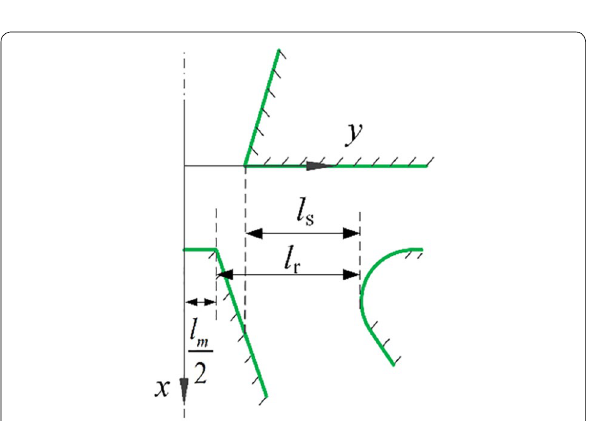
Figure 22 Effective working length of the receiver